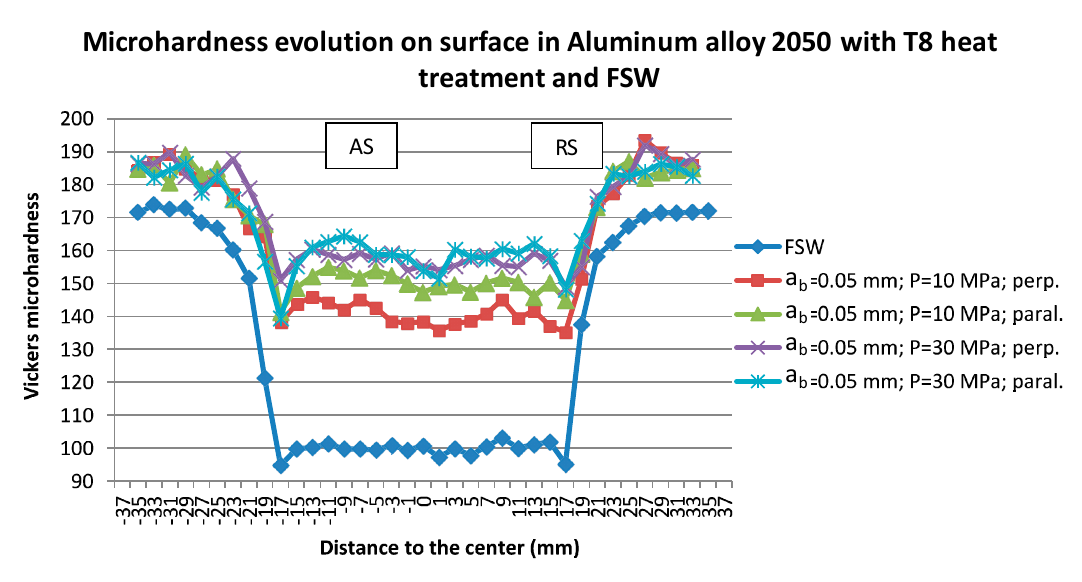
Figure 11. Example of damaged surface due to the use of aggressive parameters.